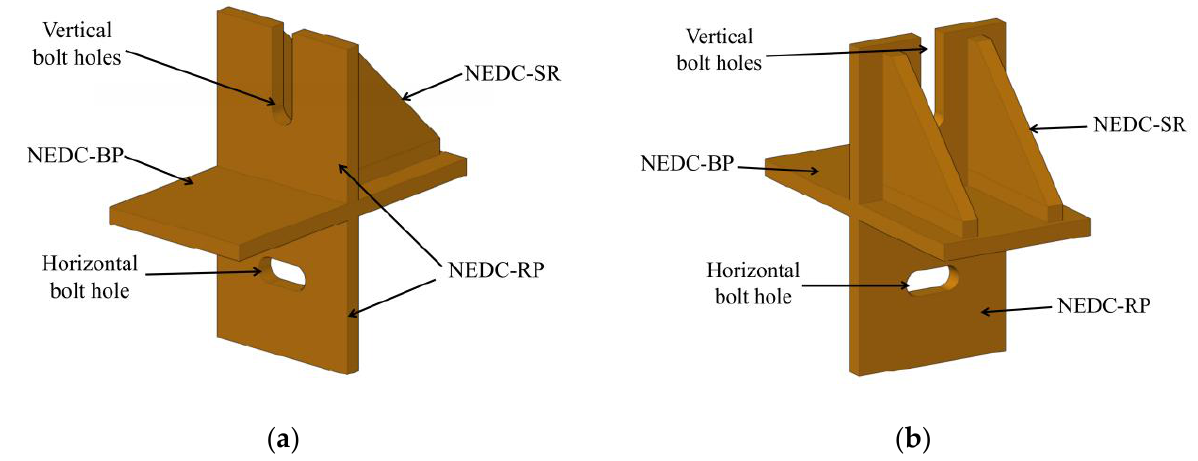
Figure 1. Schematic depicting the structure of the new energy dissipation connector (NEDC): ( a ) front view; ( b ) rear view.